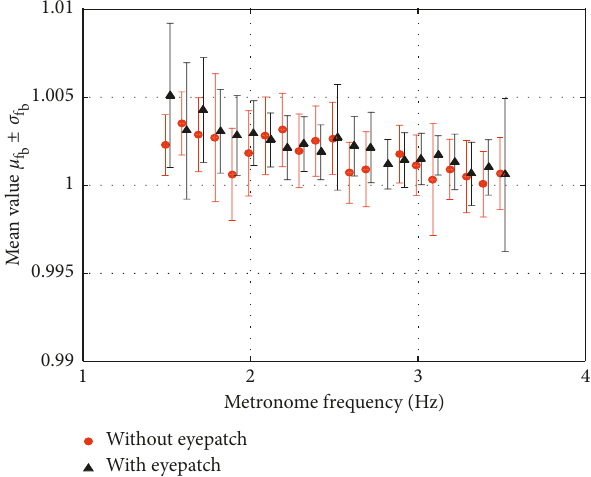
Figure 33: Comparison of the normalized achieved bouncing frequency for visual stimuli, with and without an eyepatch.